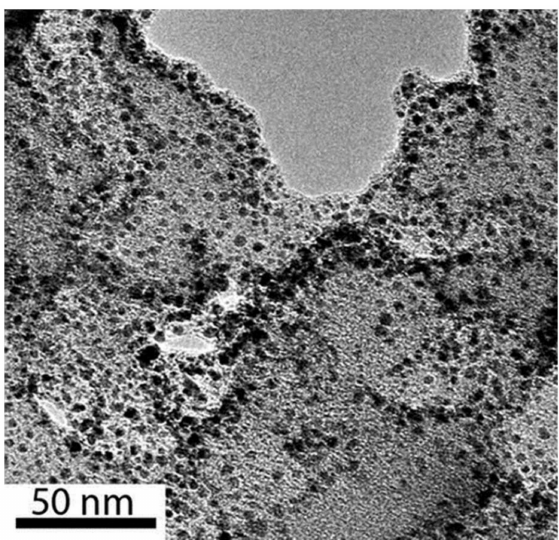
Figure 6. TEM image of Pt nanoparticles deposited in carbon aerogel by employing ALD. Reprinted with permission from Reference [100]. Copyright (2008) ACS Publications.